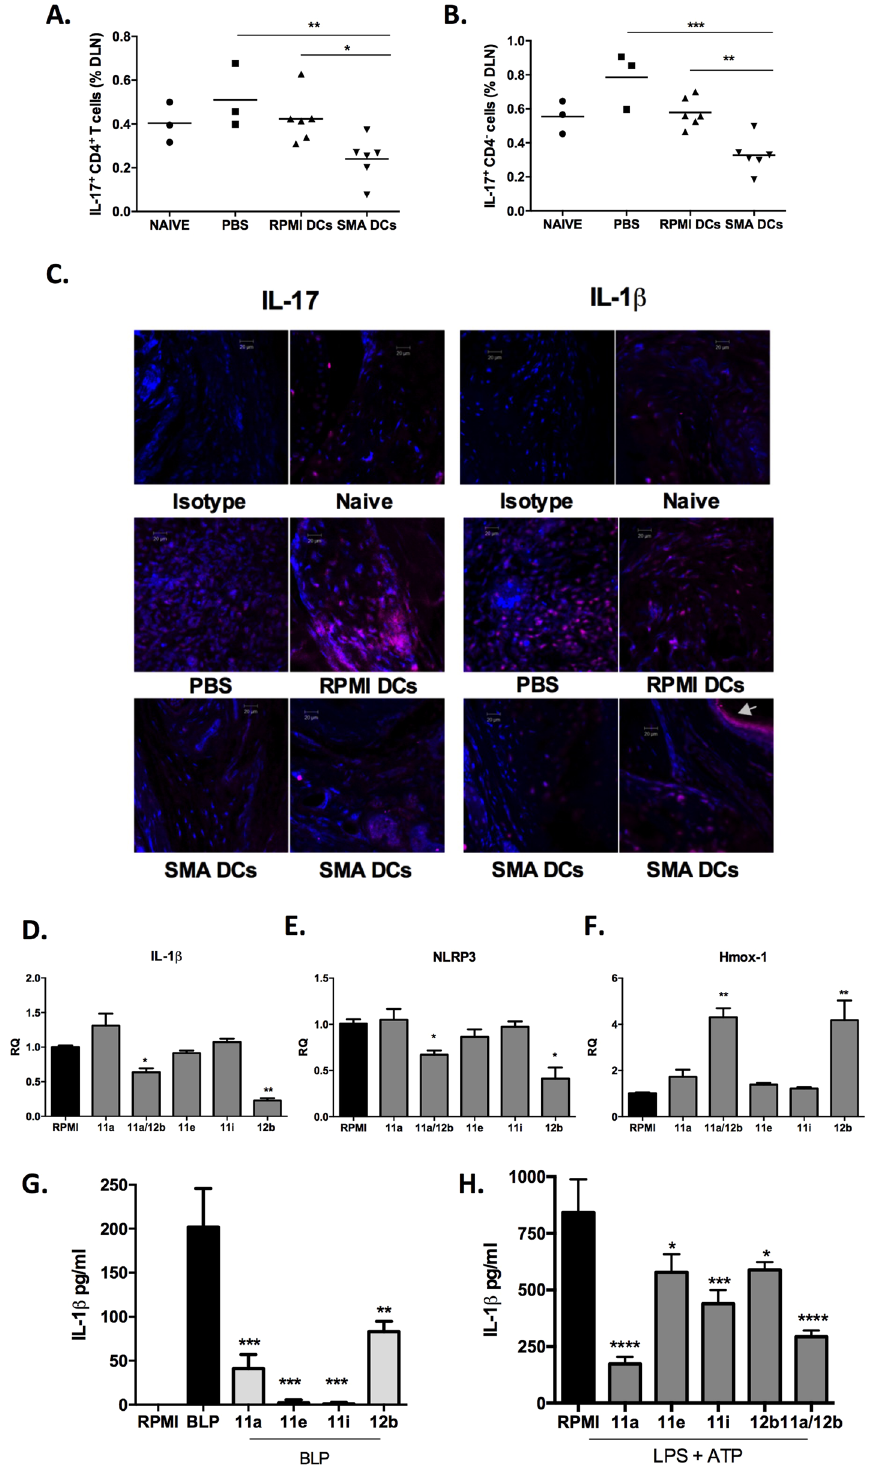
Figure 5. SMA-treated bmDCs inhibit IL-17 and IL-1 β responses. The percentage of IL-17-expressing CD4 + cells ( A ) and IL-17-expressing CD4 − cells ( B ) in the DLNs from paws from naïve or CIA-mice treated with PBS, RPMI-DCs or SMA-DCs was determined by flow cytometry. Results from individual mice in each group (Naïve n = 3, PBS n = 3, RPMI-DCs n = 6 and SMA-DCs n = 6) are shown. Data are compared using one way ANOVA and Fishers LSD test where * p < 0.05 ** p < 0.01. ( C ) Joint sections from individual mice representative of each treatment group were assessed for IL-17 and IL-1 β expression by immunofluorescence (magnification 20x; scale bars 20 μ m). The strong IL-1 β positive staining in the SMA-DCs image (denoted by white arrow) reflects high production of IL-1 β by keratinocytes in the skin and is an additional control for antibody specificity 40 . BmDCs were incubated with the indicated SMAs (5 μ g/ml) for 4 hours, the RNA was extracted and the expression